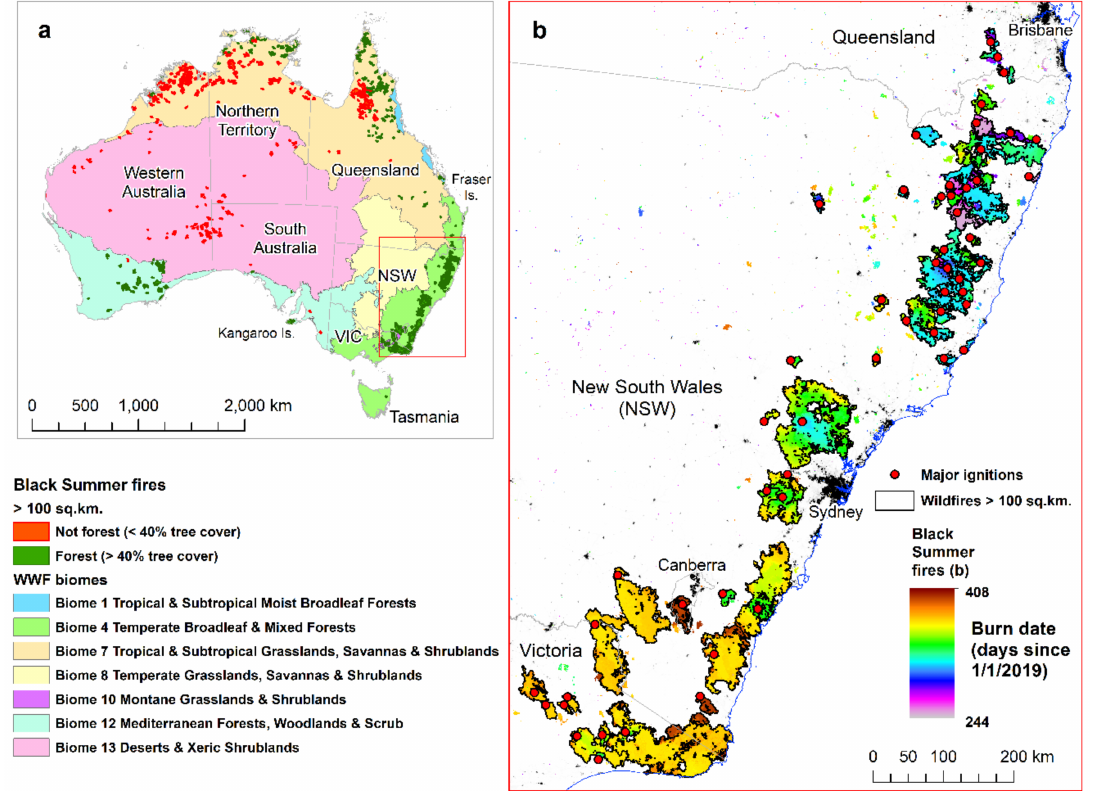
Figure 1. ( a ) Map of wildfires included in this study (Black Summer fires: Sep 2019 to mid-Feb 2020) classified by forest and not-forest based on their tree cover (below or above 40%, based on Australia’s national tree cover layer; Table 1). The map also shows the seven major biomes of Australia, based on the World Wildlife Foundation (WWF) classification of terrestrial ecosystems. Subset ( b ) focuses on many of the forest fires in SE Australia, with wildfires greater than 100 km 2 outlined by polygons. The approximate starting (ignition) point of all large fires is shown by a red dot. The burn date colours signify the date in which a certain area was burnt (based on VIIRS and MODIS), with the burn date representing the number of days since 1 January 2019 for the Black Summer